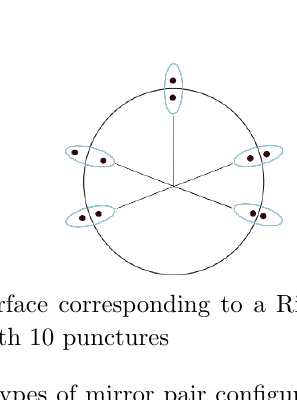
Figure 1. This diagram provides a visualization of the types of mirror pair con(cid:12)gurations under consideration and displays the OPE channel used. The dots represent heavy operator insertions on the radial plane. The left con(cid:12)guration potentially forms a stationary black hole, the right con(cid:12)guration is not expected to be stationary at late time. All the encircled pairs are contracted by the OPE and exchange identity blocks with the other